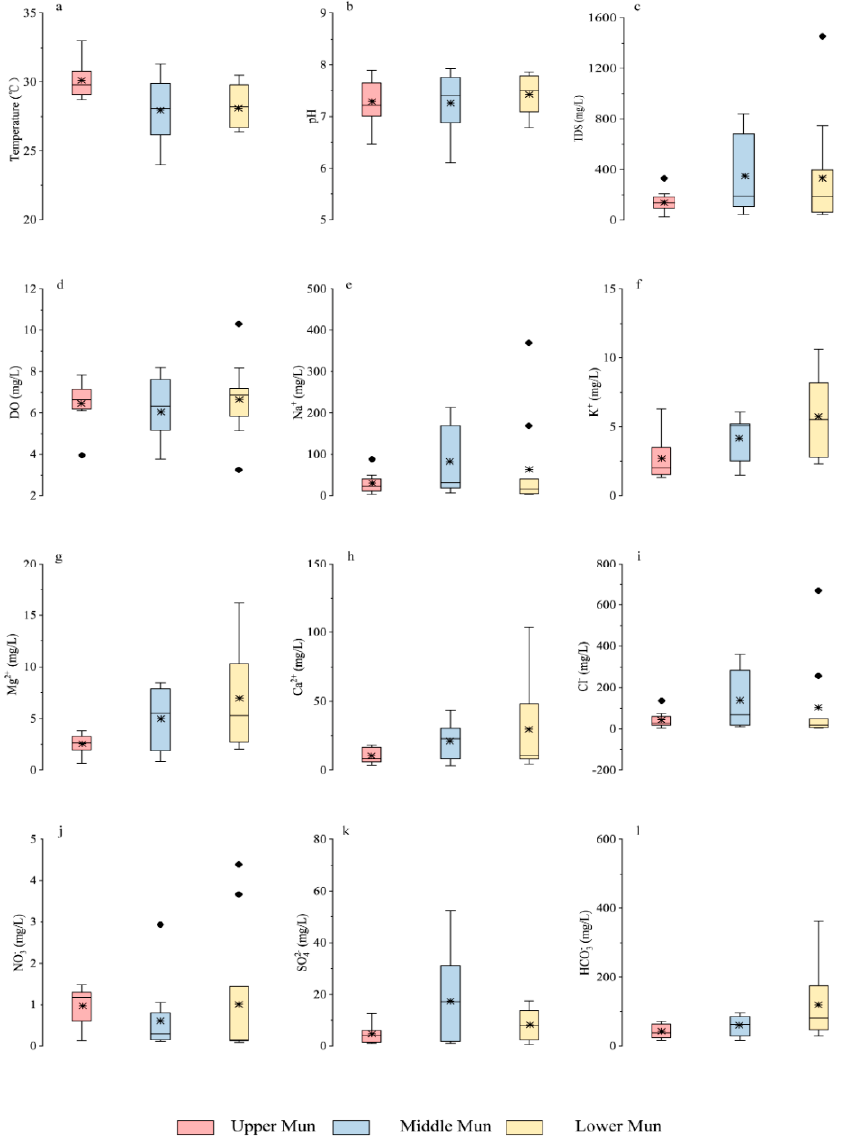
Figure 3. Box plots of ( a ) temperature ( b ) pH ( c ) TDS ( d ) DO in the MRB and the concentration of ( e ) Na + ( f ) K + ( g ) Mg 2+ ( h ) Ca 2+ ( i ) Cl − ( j ) NO 3 − ( k ) SO 42 − ( l ) HCO 3 − in the MRB tributaries. Note that ● represented the respective outliers, and * represented the mean values.